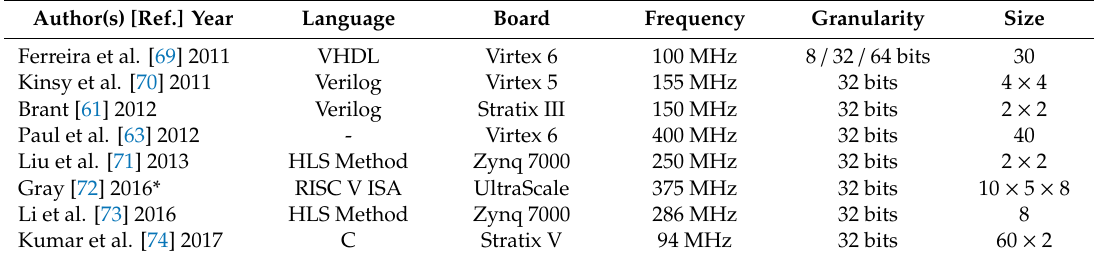
Table 4. Summary of CGRA based Overlays (*only industrial work) .